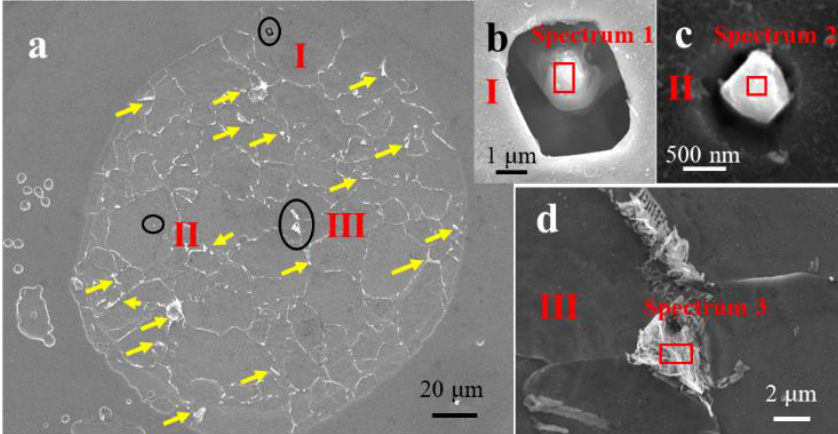
Figure 7. ( a ) SEM image of the corrosion spot after removing the corrosion product; ( b ) inclusion in position I; ( c ) nanoscale inclusion of position II; and ( d ) pearlite in position III. Table 2. Composition of the microstructures in Figure 7 (wt %).